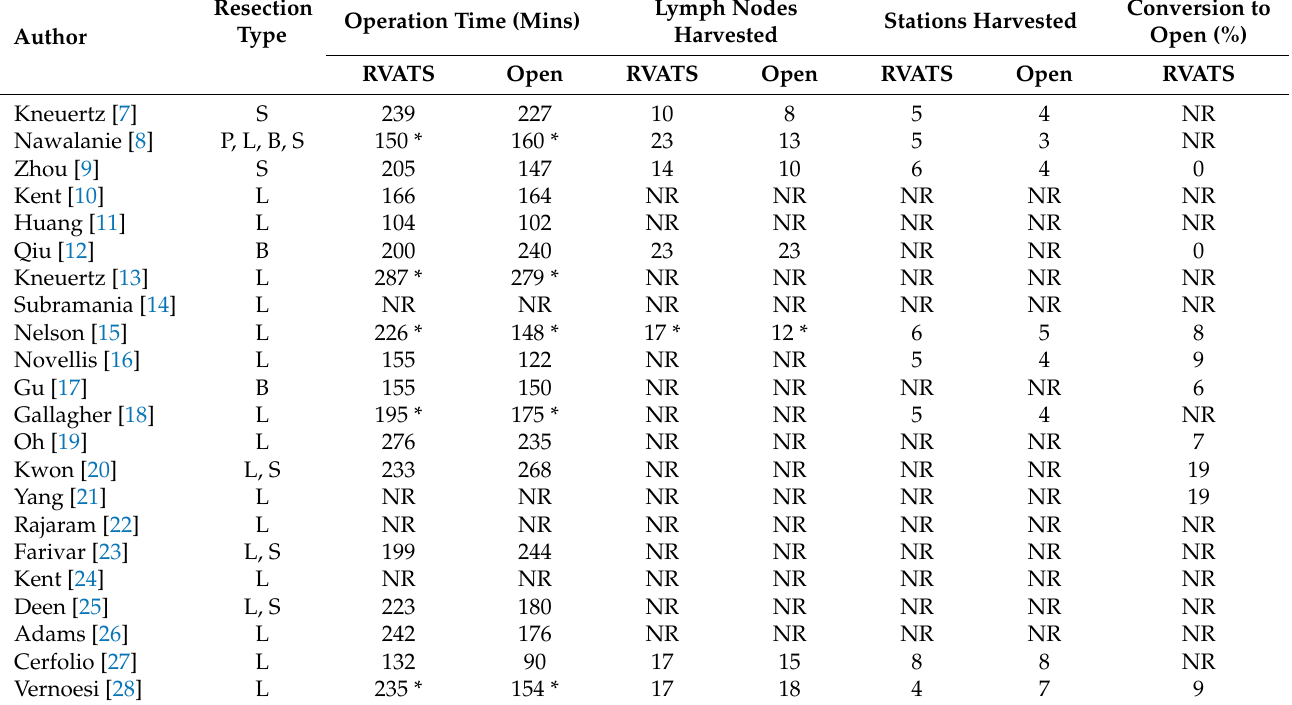
Table 3. Summary of intraoperative outcomes of patients who underwent robotic video-assisted thoracoscopic surgery compared with open thoracotomy for resectable non-small cell lung